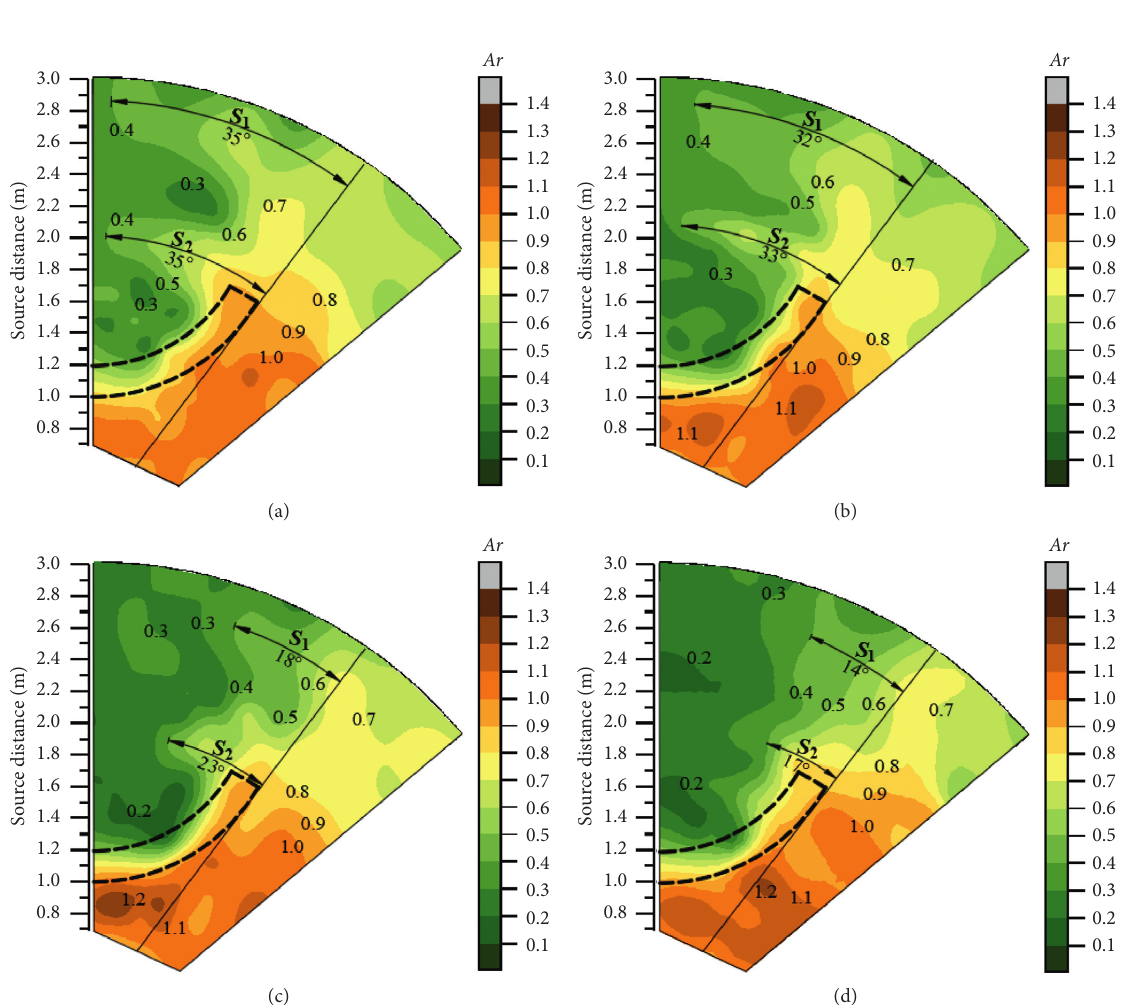
Figure 5: Amplitude reduction ratio contour map for test conditions (a) 1-5, (b) 1-6, (c) 1-7, and (d) 1-8.